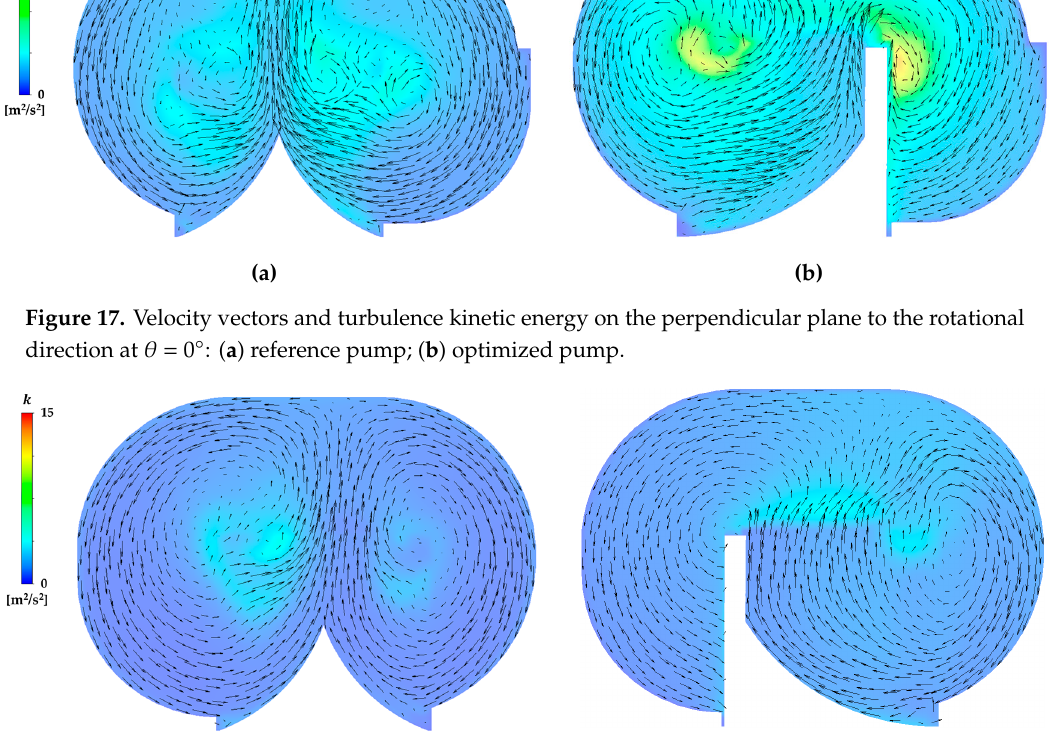
Figure 18. Velocity vectors and turbulence kinetic energy on the perpendicular plane to the rotational direction at θ = 120°: ( a ) reference pump; ( b ) optimized pump.